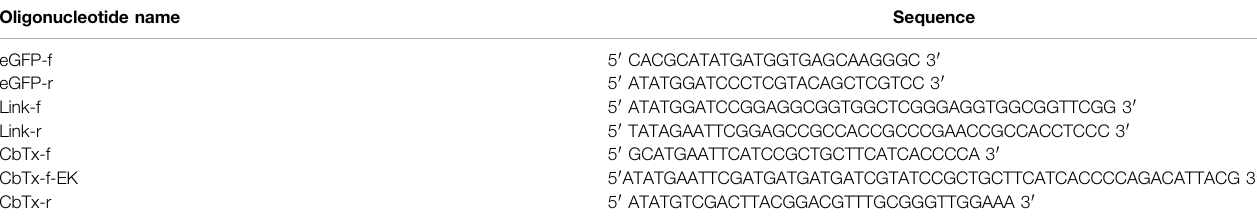
TABLE 1 | List of oligonucleotides used for eGFP – α -CbTx and eGFP – EK- α -CbTx gene